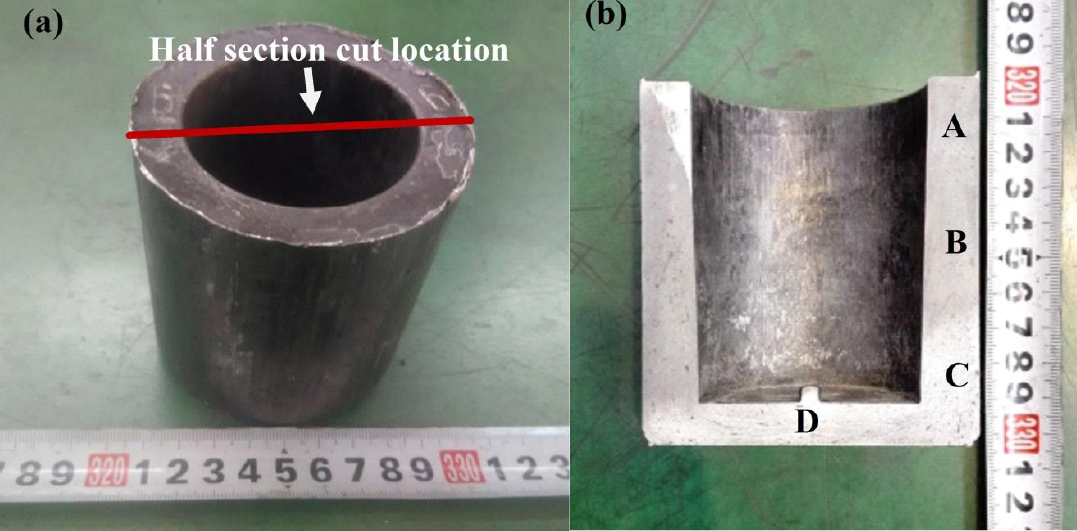
Figure 4. Whole and half-sectional macrographs of rheoformed 2024 aluminum matrix composite component reinforced by 5 vol % Al 2 O 3 nanoparticles at 620 °C and for 25 min stirring time ( a ) whole macrograph; ( b ) half-sectional macrograph.